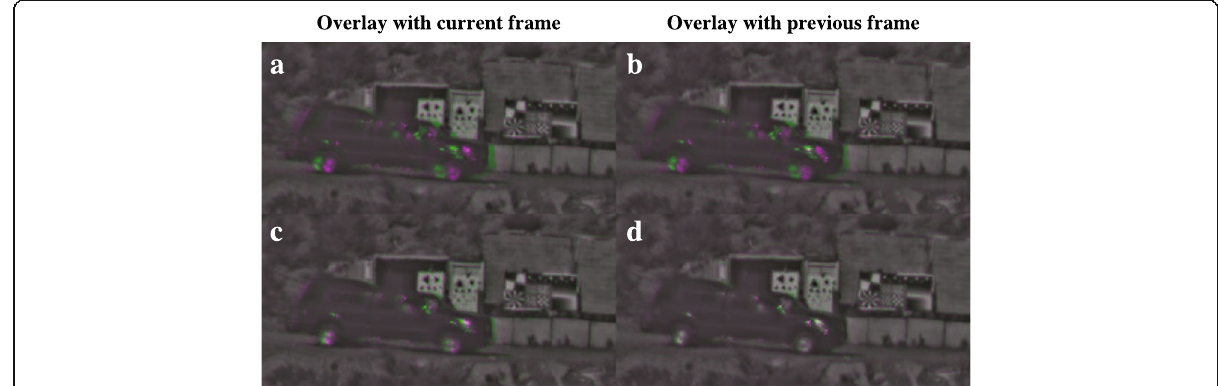
Fig. 10 Stabilization result for the truck sequence in Fig. 5. Overlays are shown between the stabilized processing result in magenta and the corresponding raw frame (left) and preceding raw frame (right). In ( a , b ), the stabilization does not distinguish between background and moving object. In ( c , d ), the stabilization results are shown when the stabilization is modified to take into account moving objects, which leaves an overlay with less color and hence less mismatch between the stabilization output and particularly the previous raw